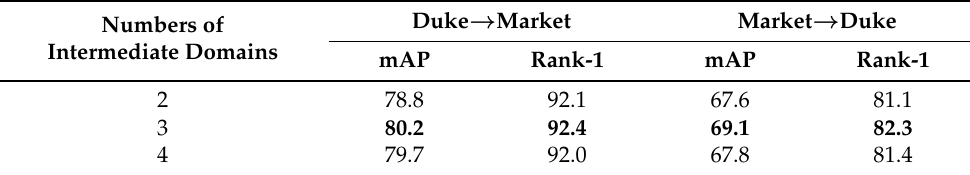
Table 5. The effect of numbers of intermediate domains on the performance of the